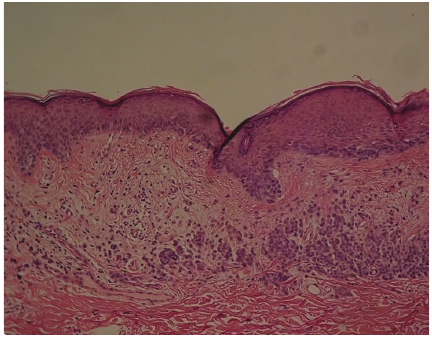
Figure 7: Histopathology for Figure 3(a), melanoma 0.55 mm